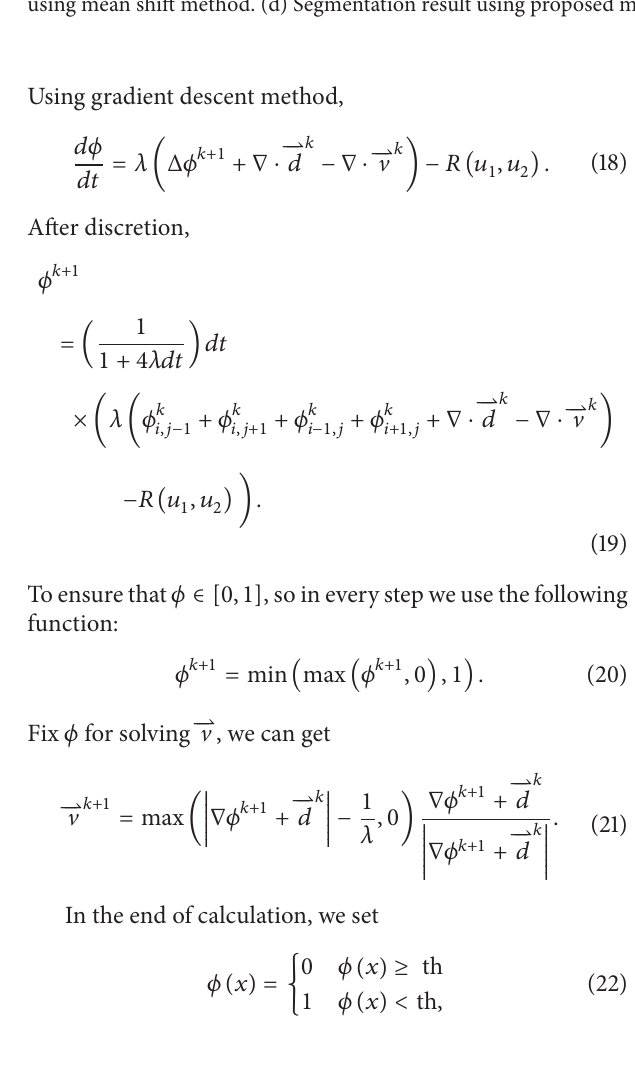
Figure 4: Experiments for an MR image of bladder. (a) Original image. (b) Segmentation result using CV model. (c) Segmentation result using mean shift method. (d) Segmentation result using proposed